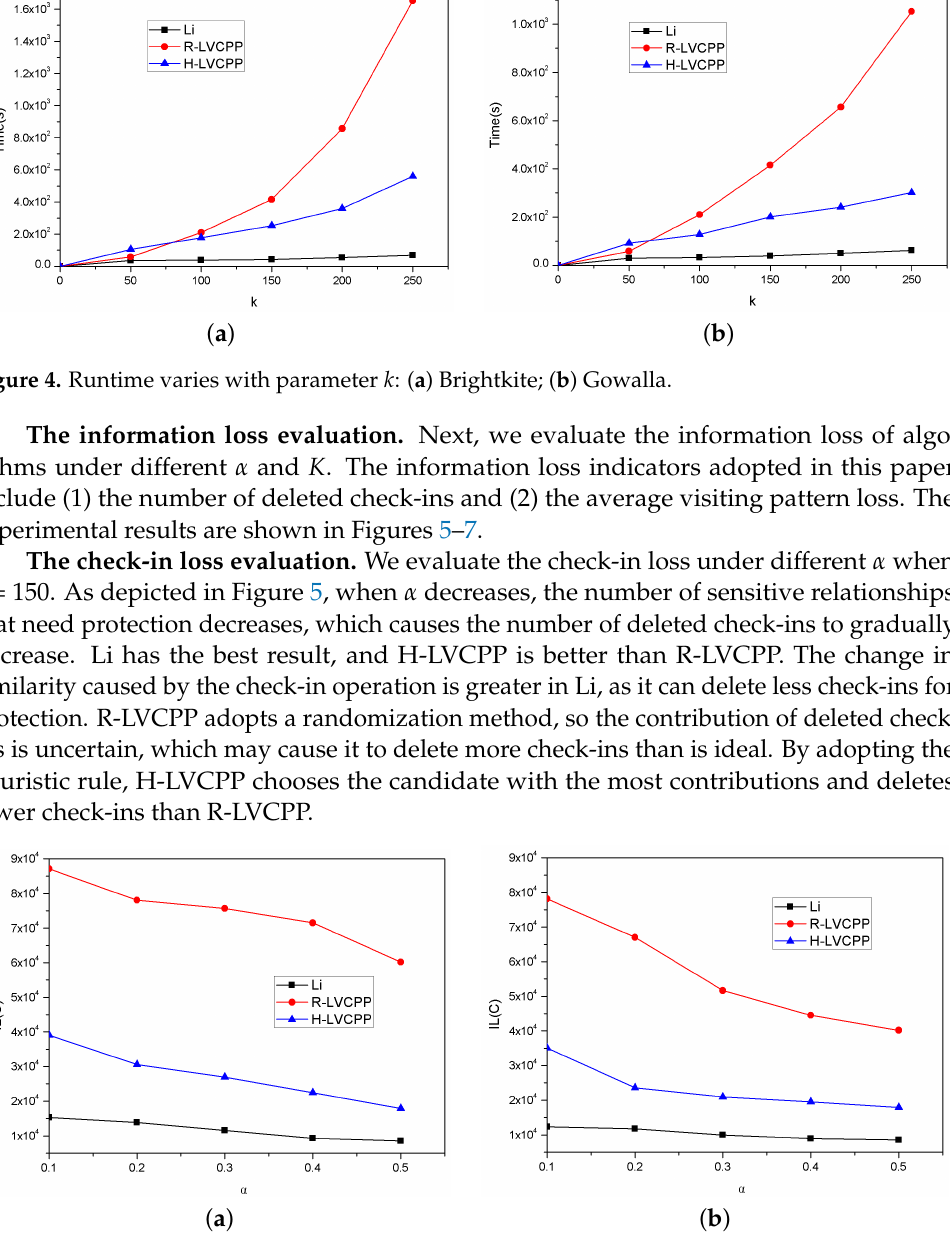
Figure 5. Check-in loss evaluation under different α : ( a ) Brightkite; ( b )